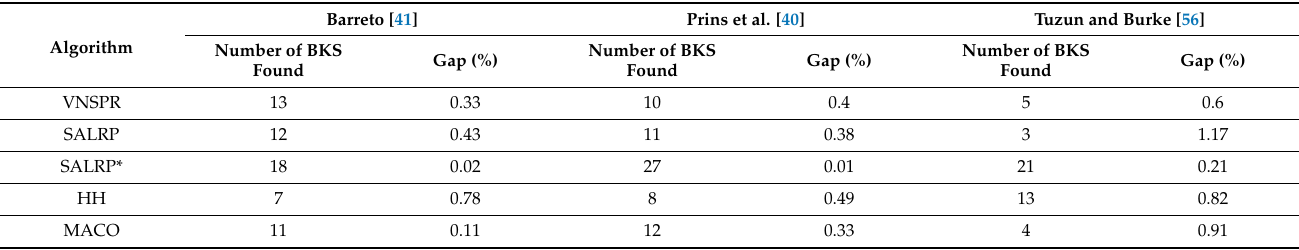
Table 5. Computational results CLRP for all instances compared with other